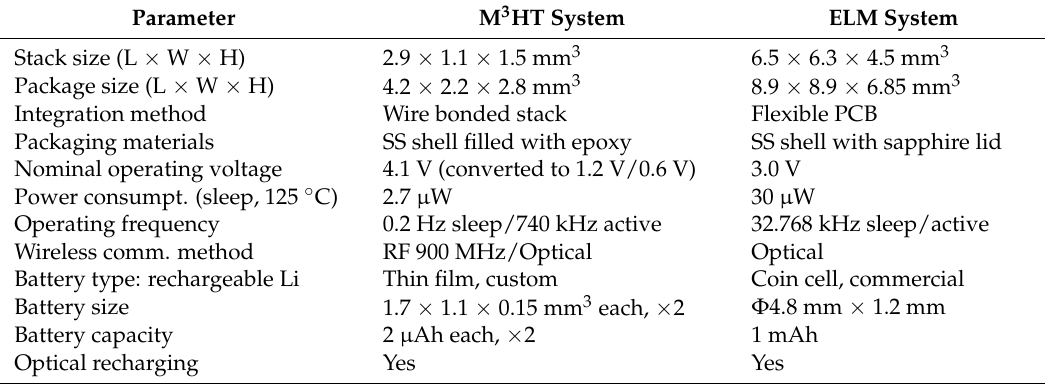
Table 1. Design and performance parameters of the M 3 HT and ELM